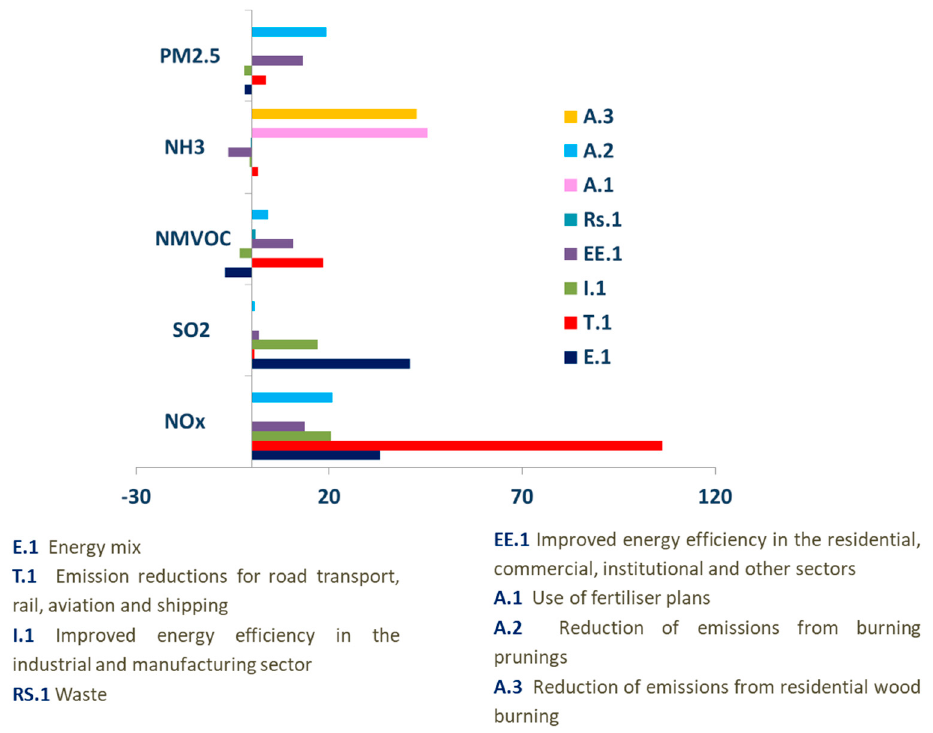
Figure 2. Contributions of the different measures to the reduction in emissions for each pollutant.